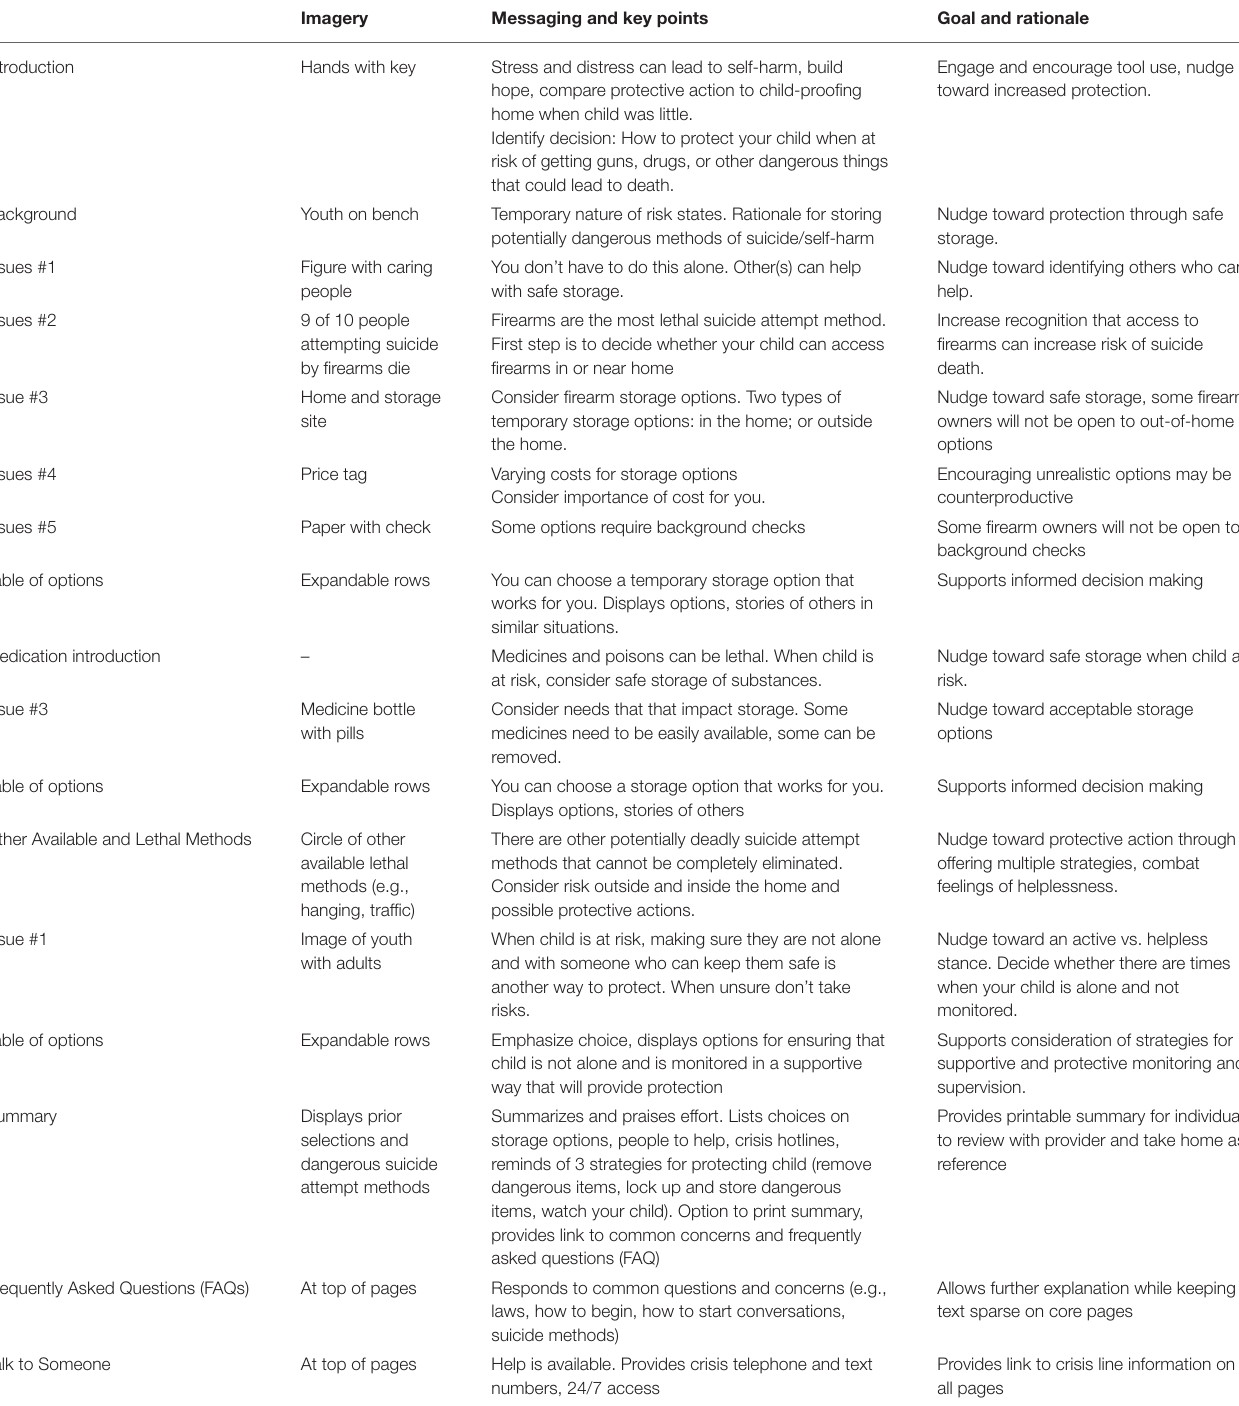
TABLE 2 | Summary of “Lock and Protect” sections, key elements, and goal and rationale for each section.